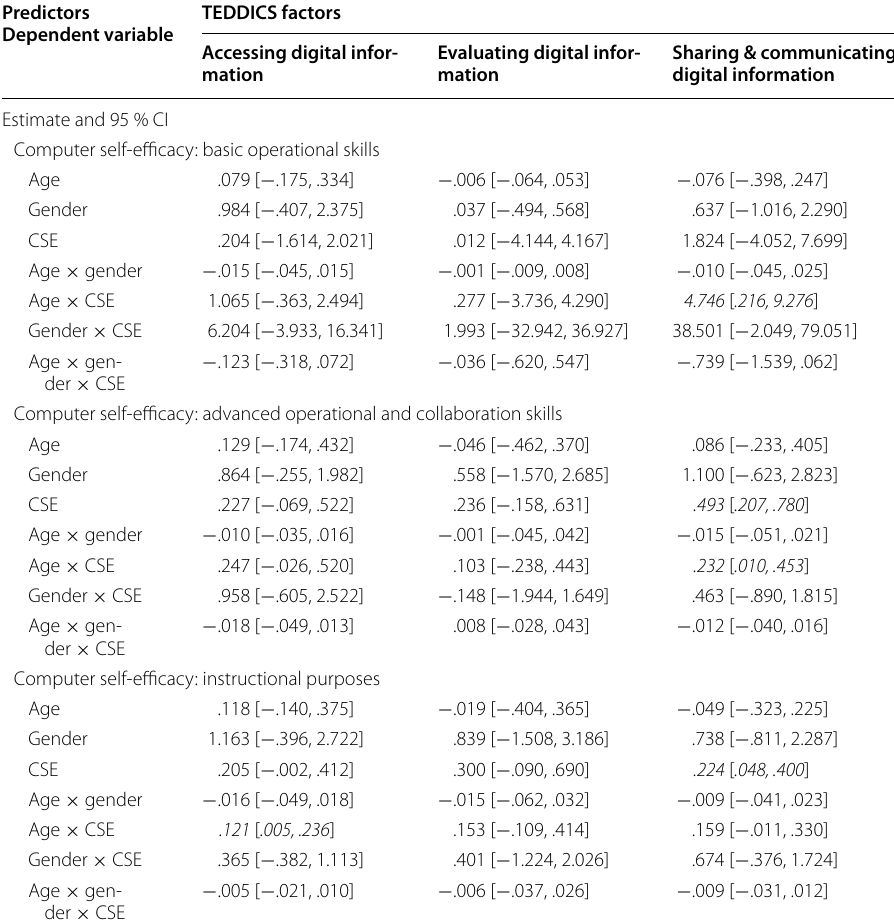
Table 6 Regression models testing the moderation effects of teachers’ age, gender, and their interaction on the relation between TEDDICS and CSE